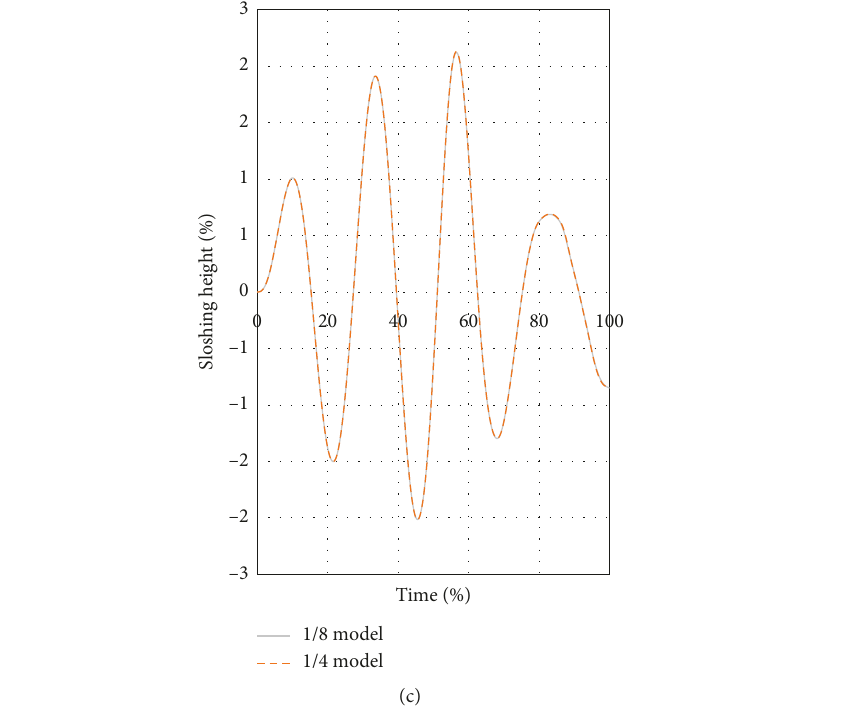
Figure 4: Sloshing heights in the (a) 1/8 model and (b) 1/4 model. (c) Comparison of sloshing heights under low-frequency excitation.